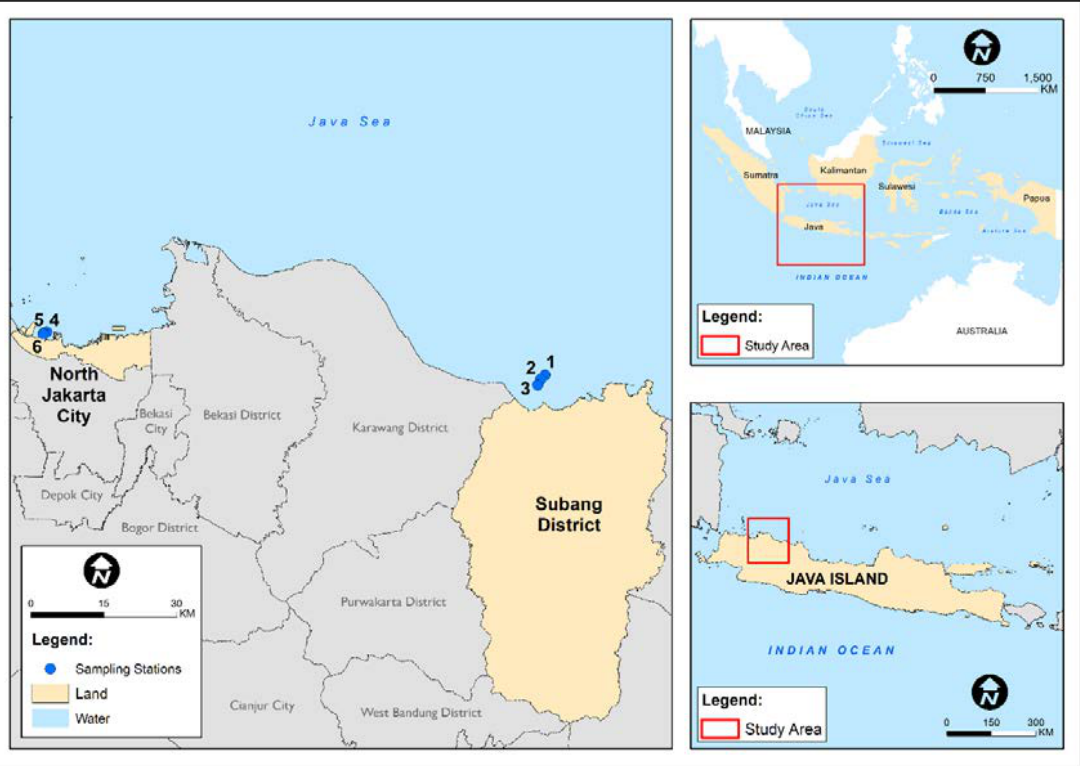
Fig. 1: Geographic location of the study area in Indonesia’s West Java coast, with Subang district in the east and Jakarta city in the west dominating settlements and mangroves, respectively